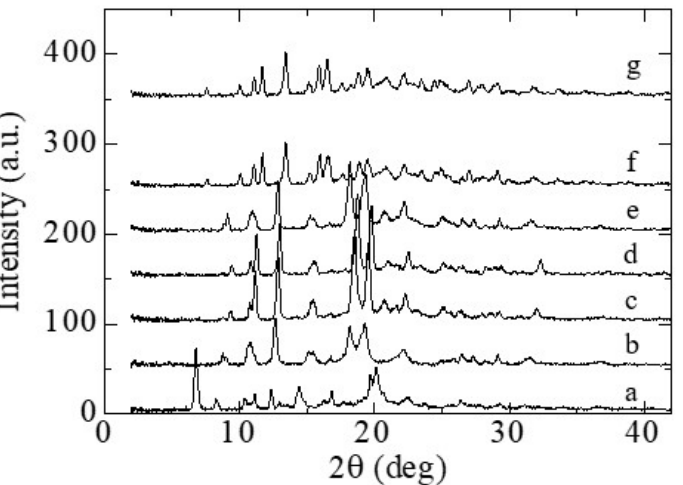
Figure 14. XRD patterns of polymorphs appeared during transition of Form A to Form H; ( a ) Form A, at the start of standing in 80% EtOH partial pressure environment, ( b ) Form A-1, standing at a partial pressure of 0% RH, ( c ) Form A-2, at 170 °C, ( d ) Form A-2, at 25 °C, ( e ) Form B, standing at 70% RH, ( f ) Form H, standing at 90% RH, ( g ) Form H, as a reference.